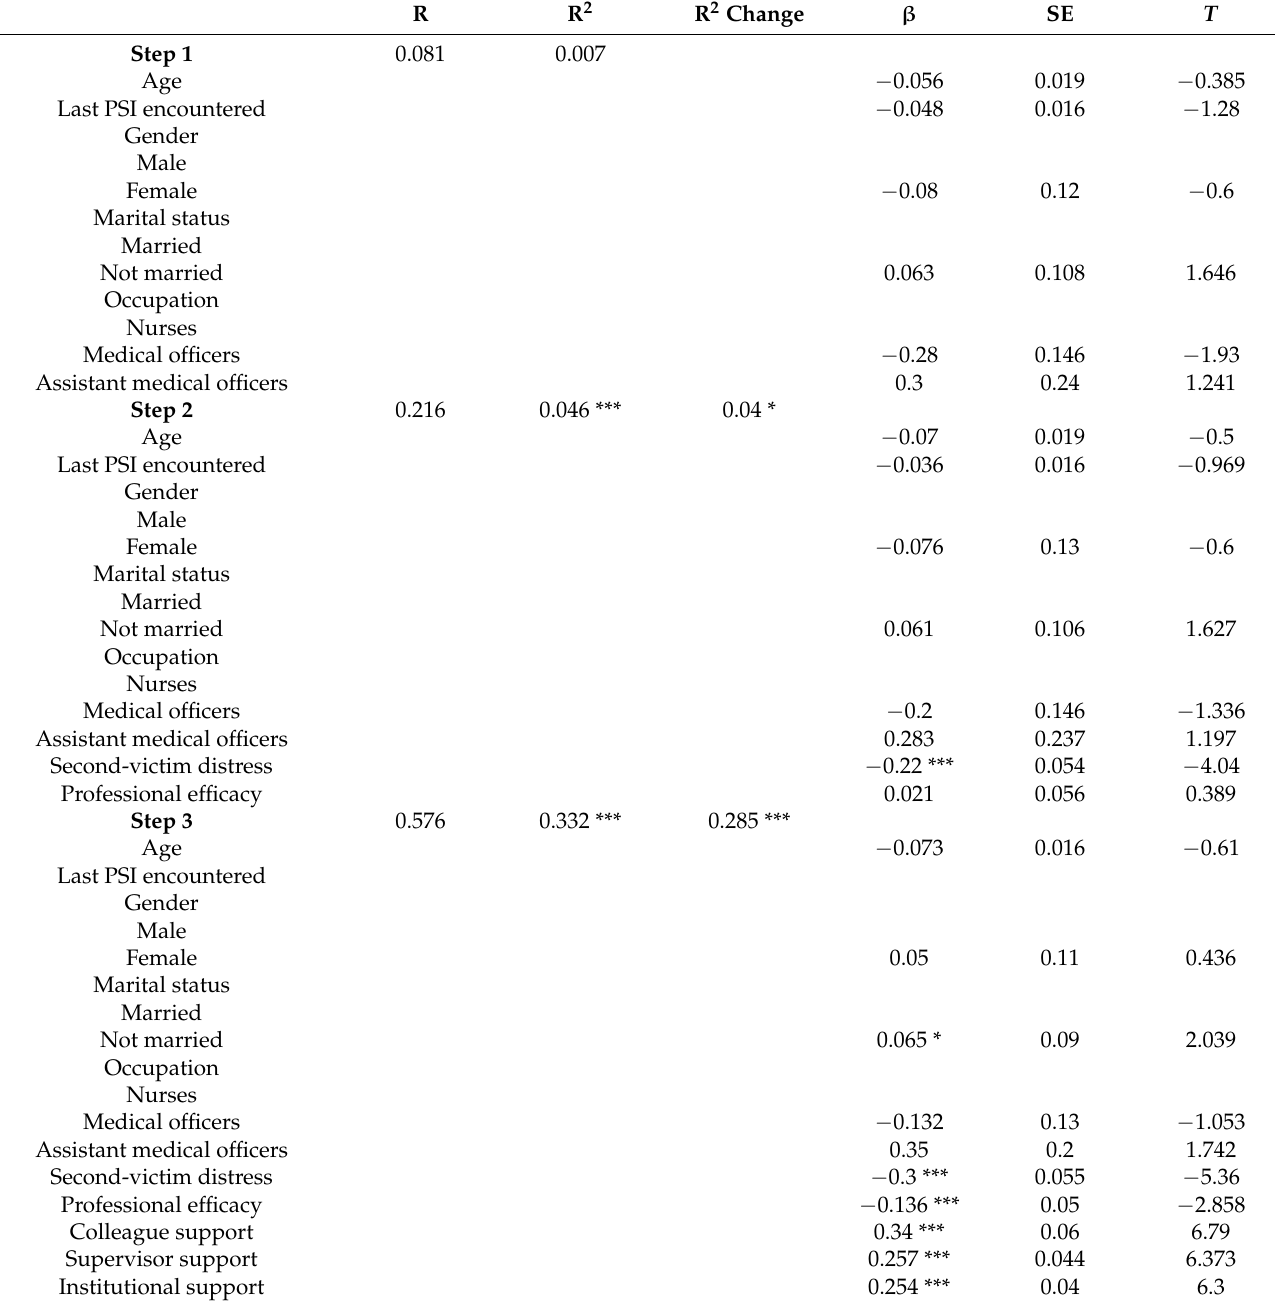
Table 3. Hierarchical regression model of